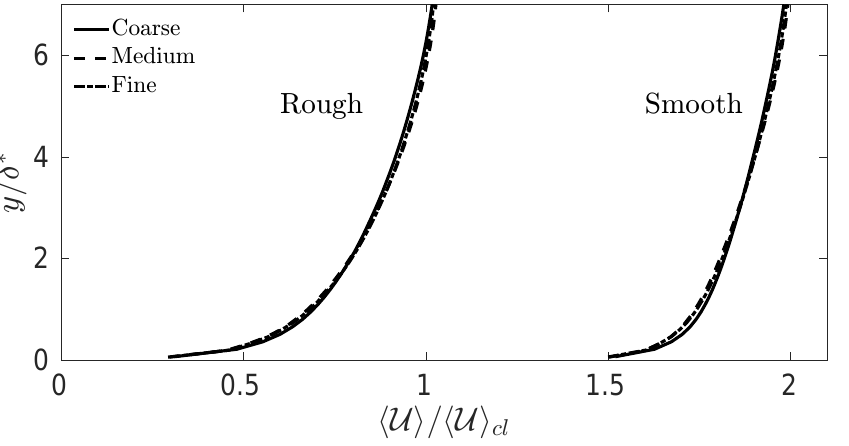
Figure 2. WMLES grid convergence study: mean velocity profiles at 95% of the length of the ( left ) rough and ( right ) smooth strips. Normalization is carried out with the center line velocity (cid:104)U(cid:105) cl and the displacement thickness δ ∗ .